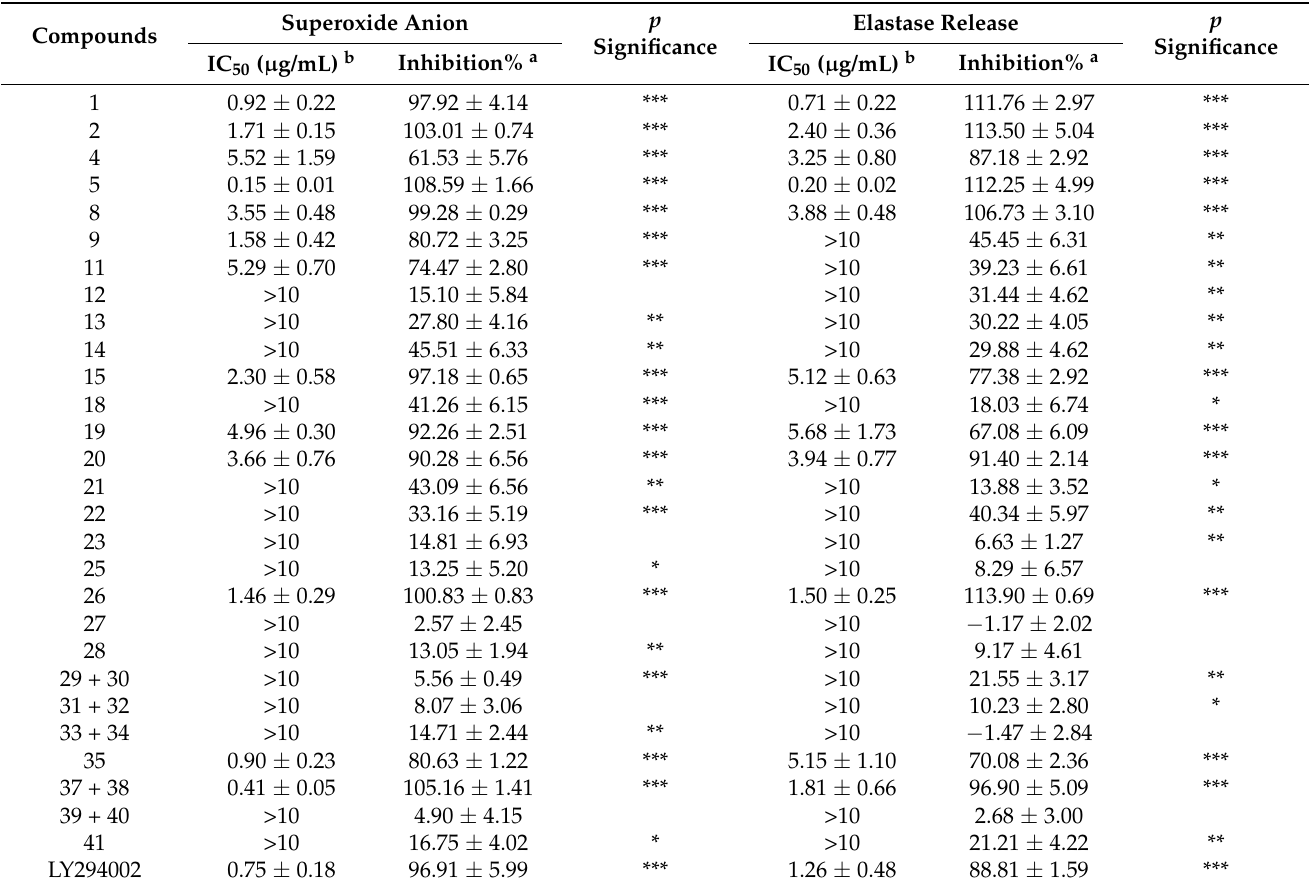
Table 3. Effects of compounds on superoxide anion generation and elastase release in fMLP/CB- induced human